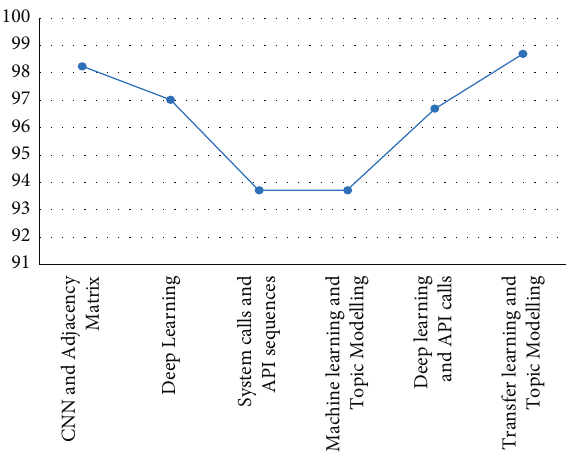
Figure 13: Comparison among different